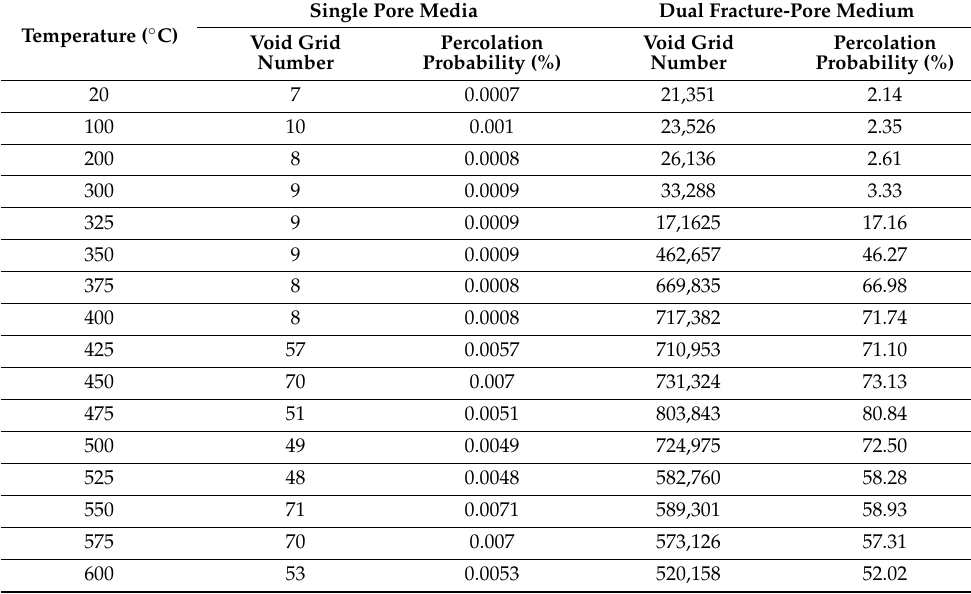
Table 1. The percolation probability of different